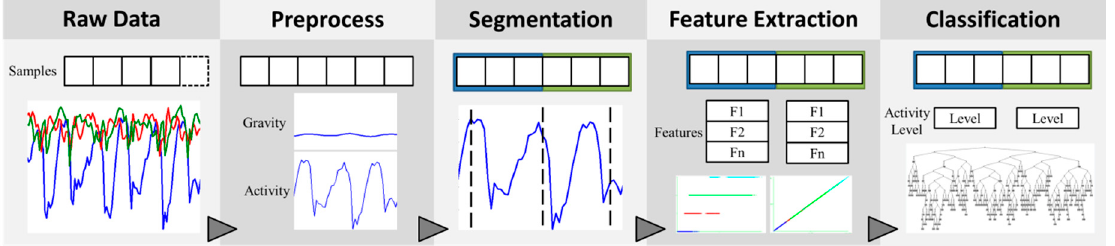
Figure 2. The multi-stage process of pattern recognition and activity level estimation.